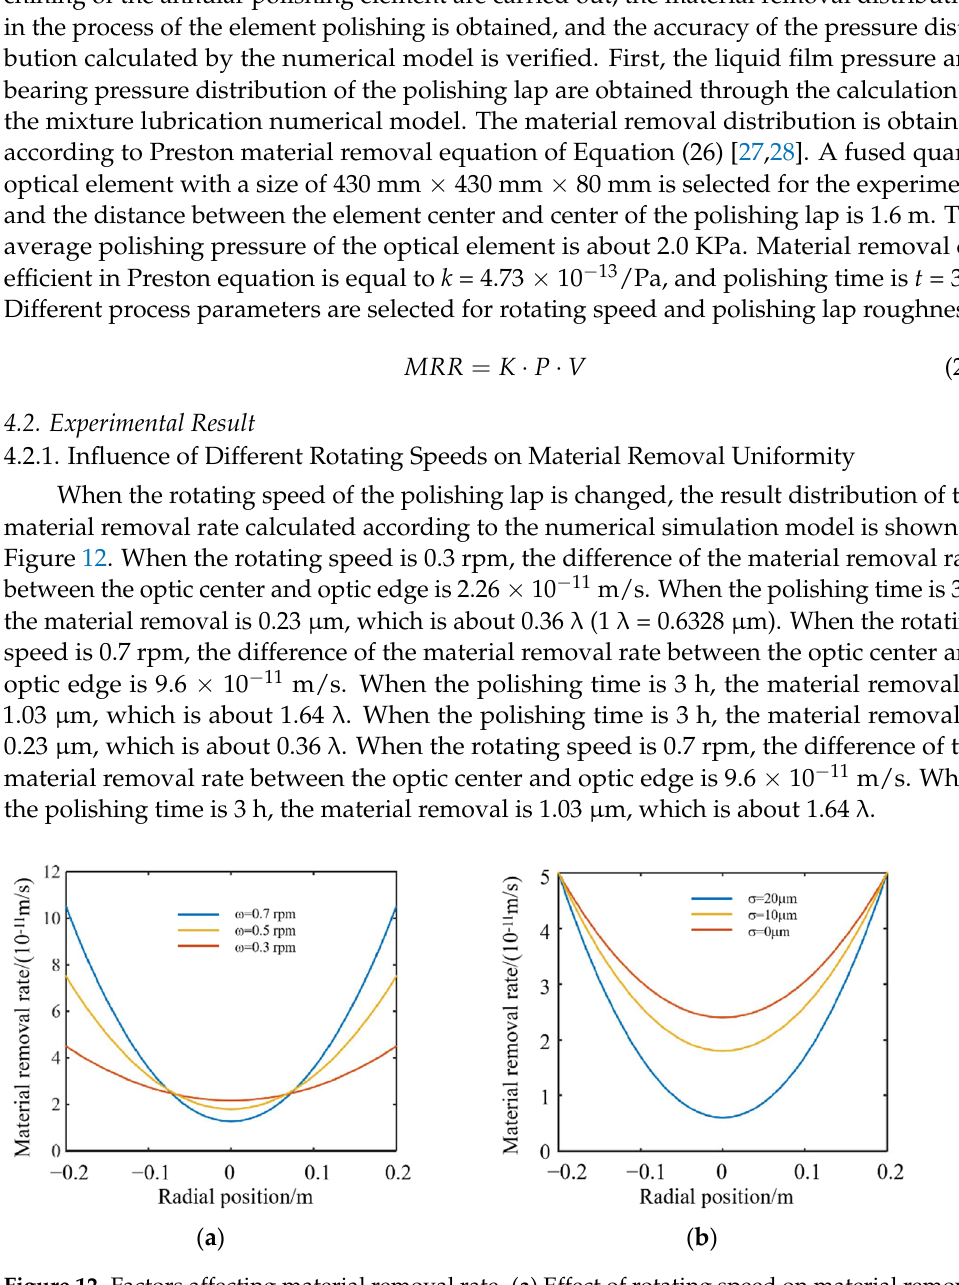
Figure 12. Factors affecting material removal rate. ( a ) Effect of rotating speed on material removal rate ( b ) Effect of roughness on material removal rate. rate ( b ) Effect of roughness on material removal